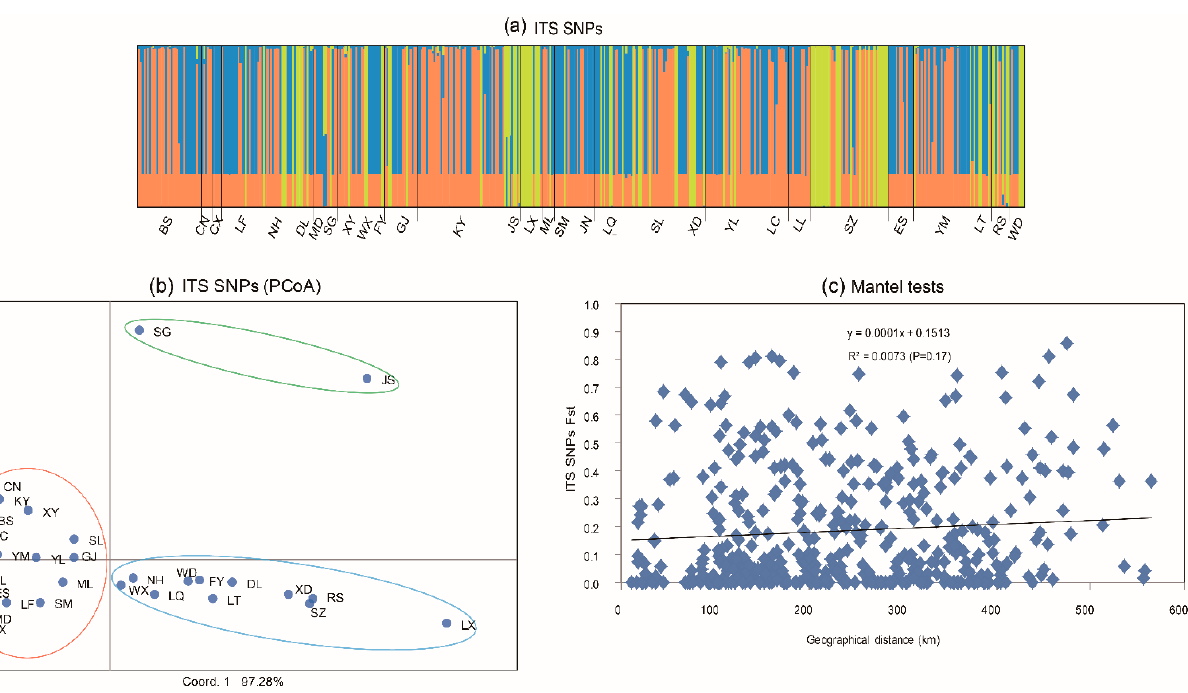
Figure 3. ( a ) Genetic clusters with STRUCTURE based on ITS SNPs; ( b ) principal coordinate analysis of 30 populations of T. ganbajun in Yunnan based on ITS Nei’s genetic distance using GenAlEx; ( c ) Mantel tests of the relationships between genetic differentiation ( Fst values) and geographical distance indicated by ITS SNPs.